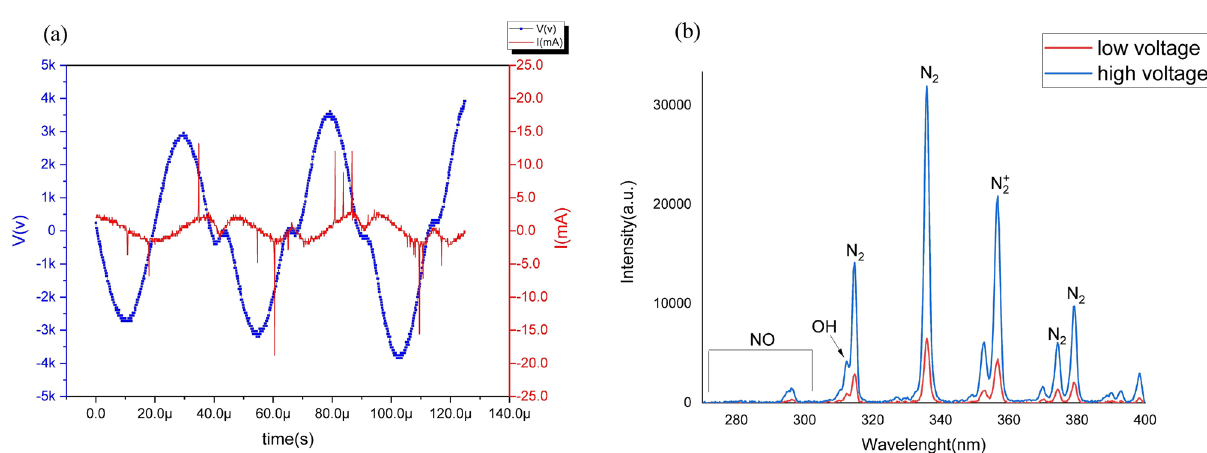
Figure 2. Characterization of cold plasma device ( a ) the voltage (blue line) and current (red line) of plasma device for the high-voltage mode, ( b ) optical emission spectra of the plasma device and excited species produced by it for both high- and low-voltage